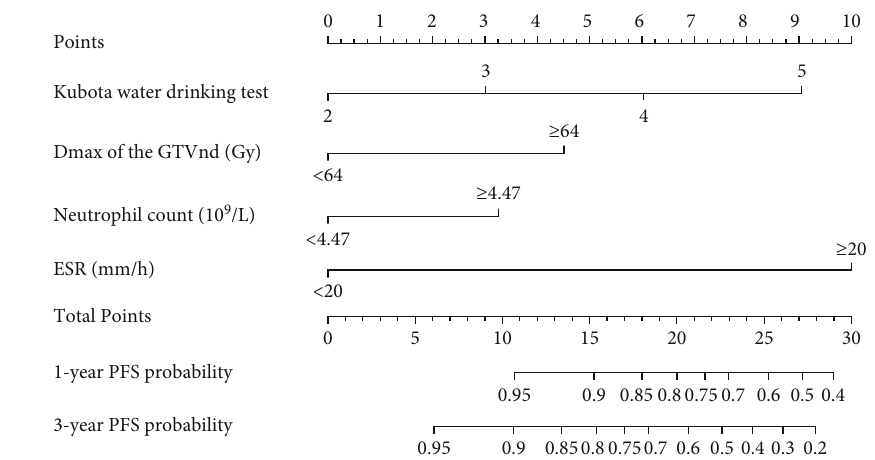
Figure 1: Nomogram to predict 1- and 3-year PFS rates. Points were assigned for Kubota water drinking test, D neutrophil count, and ESR level by drawing a line upward from the corresponding values to the “ Points ” line. The sum of these four points, plotted on the “ Total points ” line corresponds to predictions of 1- and 3-year PFS. Abbreviations: PFS: pneumonia-free survival; D of the GTVnd: the maximum radiation dose of lymph node gross tumor volume; ESR: erythrocyte sedimentation rate; RAP: max radiation-associated aspiration